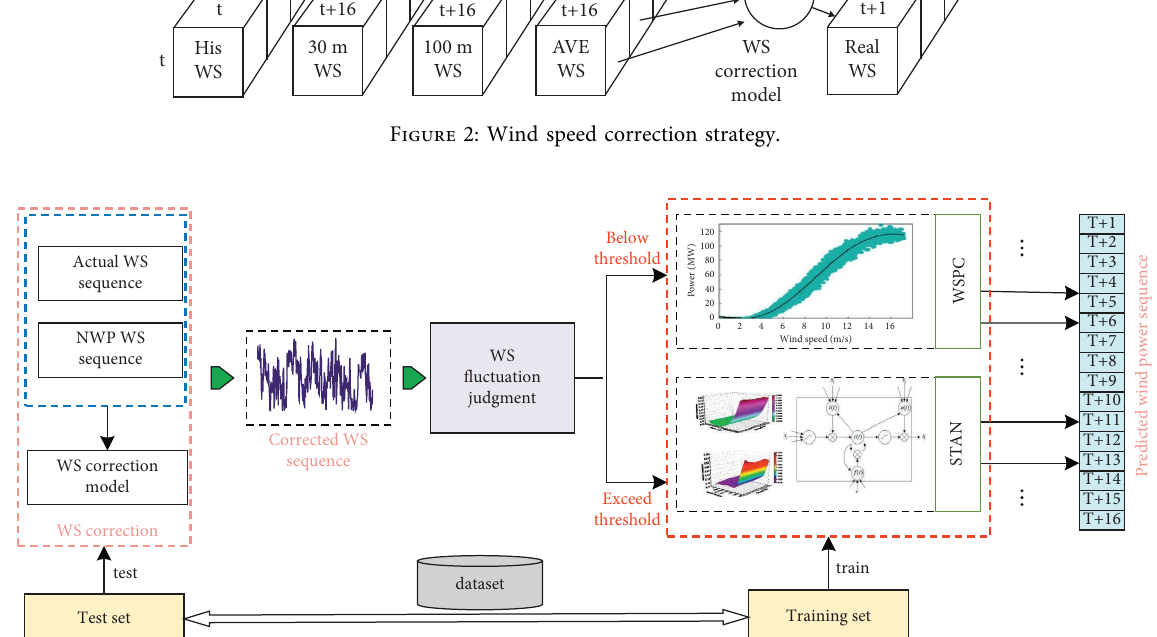
Figure 3: Technology